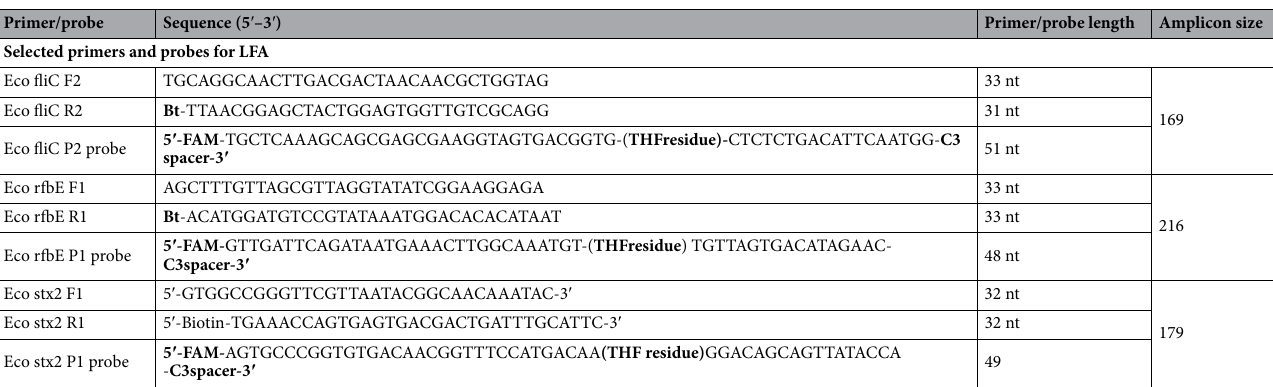
Table 2. A list of all primers and probes used in this study. Bt biotin, FAM fluorescein, THF tetrahydrofuran residue, nt